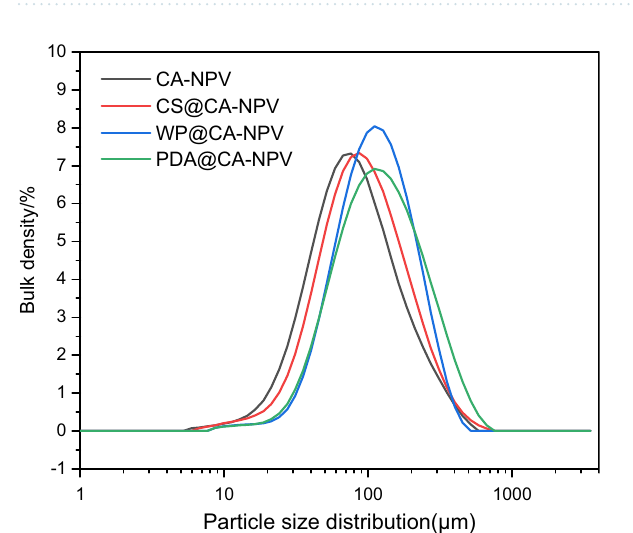
Figure 5. Surface morphology of microencapsulated preparations under SEM. The dried sample placed was placed on conductive adhesive and coated with gold using a sputter coater for 45 s. In the CA-NPV samples, shriveling due to water evaporation during the sample preparation process was observed. Observations of CS@ CANPV and WP@CA-NPV revealed that the electrostatic self-assembled microcapsules were more complete and more spherical than single-layer microcapsules. The 1,2-dihydroxybenzene and amino groups in the structure of dopamine self-oxidized and polymerized on almost any solid surface to form a dopamine coating that adhered tightly to the surface of the microcapsule.